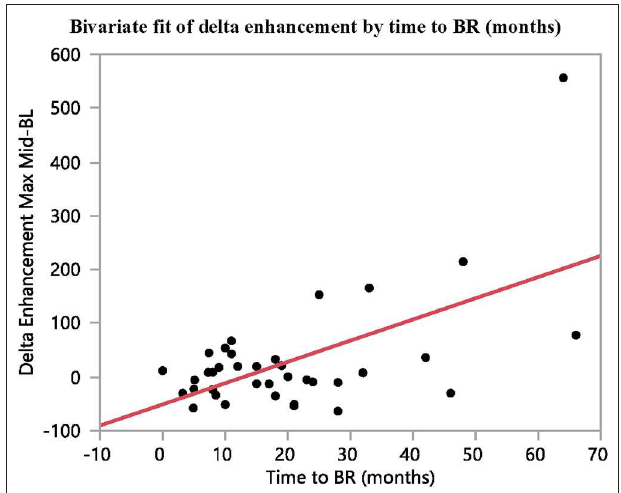
FIGURE 6 | The difference in contrast-enhancement during early stages of treatment (baseline to mid-treatment) correlates with time to BR ( n = 37, R 2 = 0.34, p =